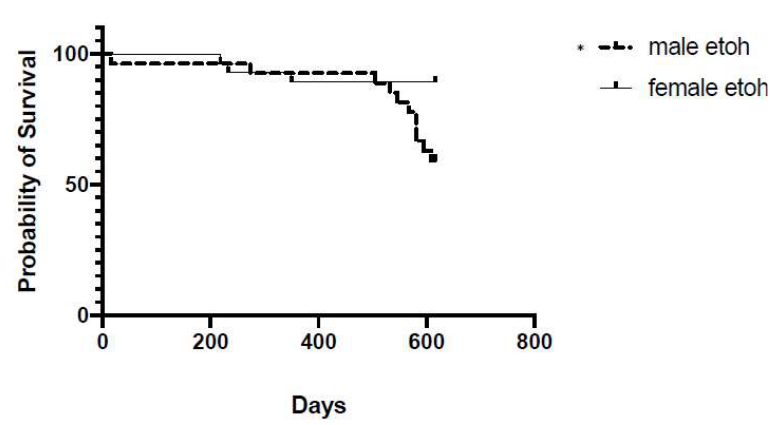
Figure 2. Survivability Curves Following Chronic Intermittent Ethanol. The probably of survival (y-axis) over days of the experiment (x-axis) for both males and females. As seen in the graph, males treated with alcohol were significantly more likely to not survive to the end of the experiment. * denotes significant difference, p = 0.017.